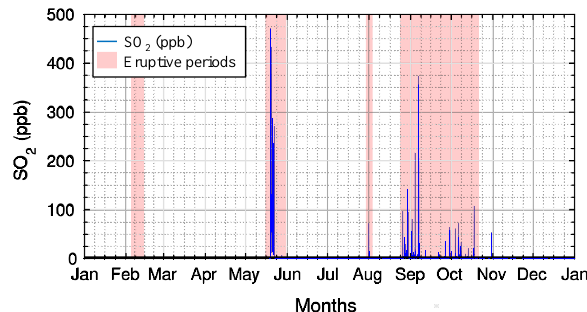
Figure A1. SO 2 concentration (ppb) at Maïdo station in 2015, showing the occurrence of three eruptive periods in red (17 to 30 May, 31 July to 2 August, and 24 August to 18 October).